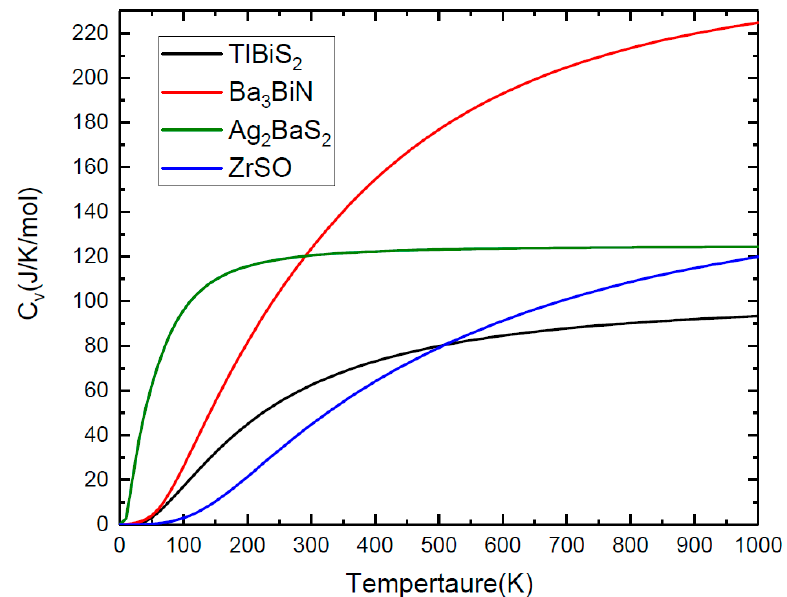
Figure 5. Calculated site projected phonon density of states for ( a ) TlBiS 2 , ( b ) Ba 3 BiN, ( c ) Ag 2 BaS 2 , ( d ) ZrSO.